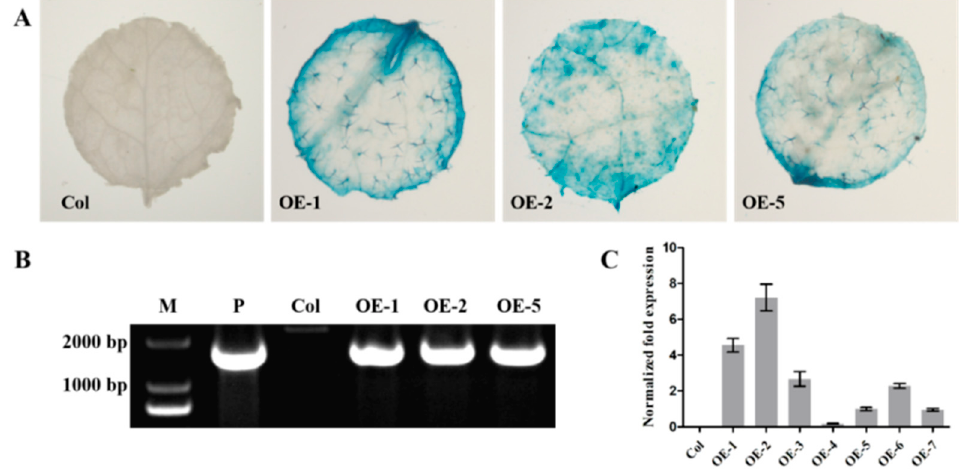
Figure 4. Identification of ectopic expression of the EjNACL47 gene in Arabidopsis . ( A ) GUS histochemical identification of transgenic plants. ( B ) PCR identification of transgenic plants; primers are 35S terminal primer and NOS terminal primer. M: marker 2000; P: positive, template is sense EjNACL47 plasmide. ( C ) Relative expression level of EjNACL47 in the transgenic plants. Error bars represent SD of three independent replicates.